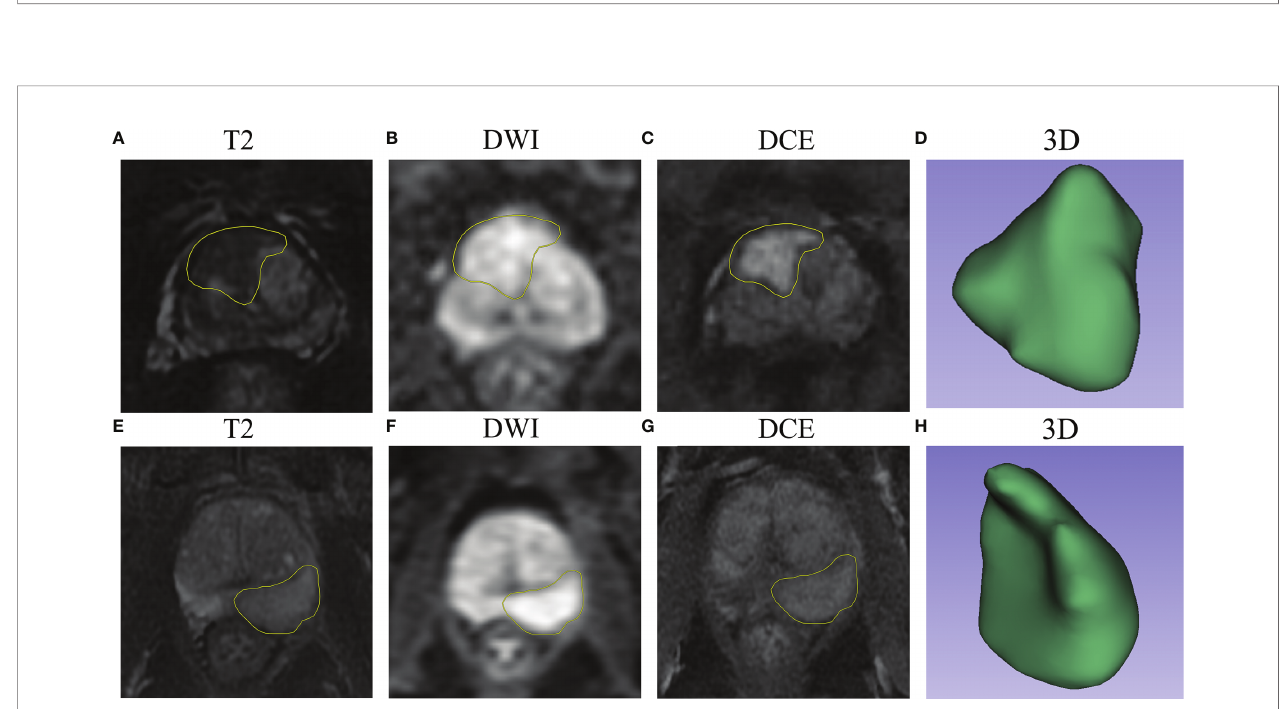
FIGURE 6 | The calibration curves and decision curve analysis of the MP-MRI models. The calibration curves (A – D) show the consistency between the prediction model and the actuality. The dotted reference line indicated perfect calibration. The DCA (E – H) illustrated the clinical net bene fi ts brought by the prediction model. The gray line indicated “ treat all, ” and the black horizontal line indicated “ treat none ” .